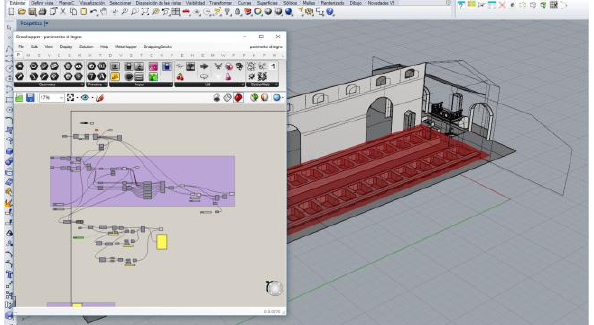
Figure 12. Parametric modeling procedures using node